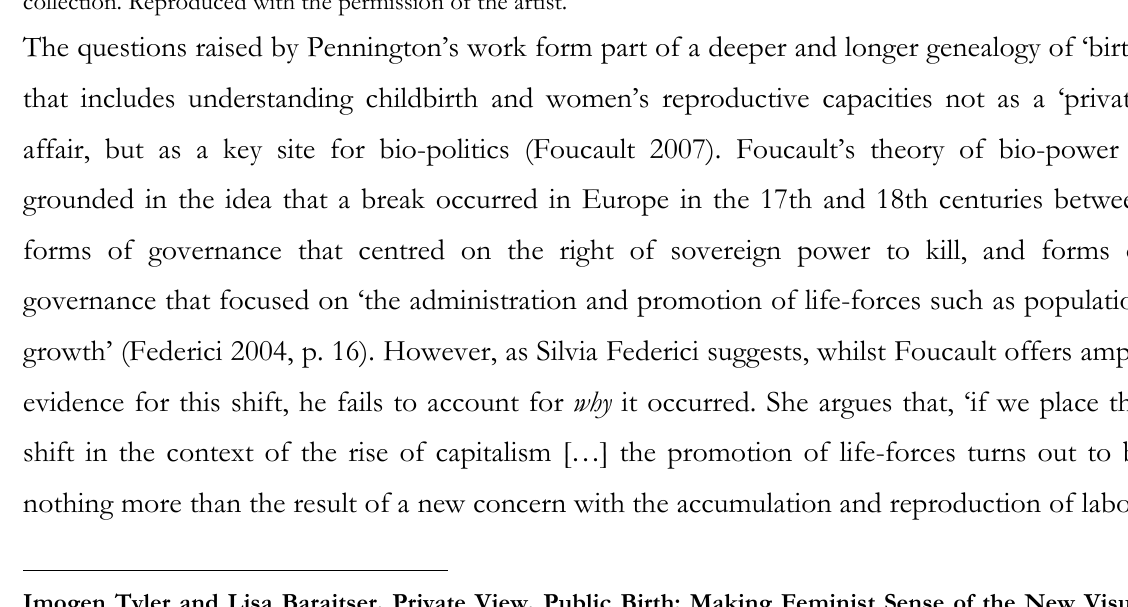
Figure 3: Liv Pennington, 2006, ‘Private View’ [detail] Digital C type on Aluminium, 80 x 76 cm, birthrites collection. Reproduced with the permission of the